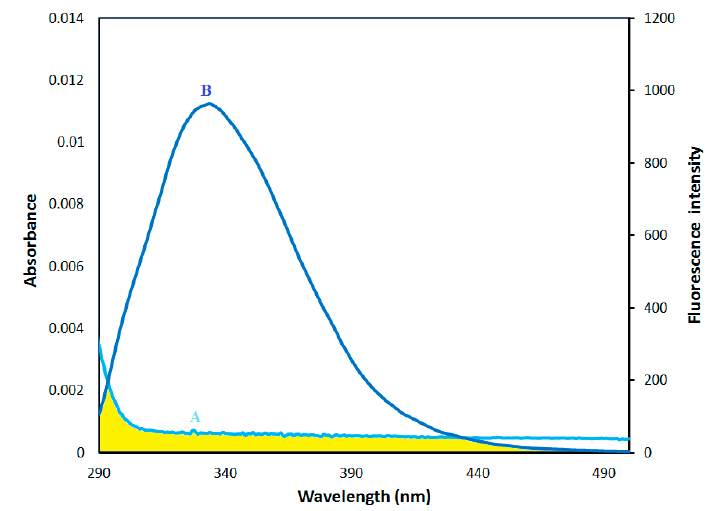
Figure 7. The overlap of (A) UV absorption spectra of AICAR (5 µ M) with (B) fluorescence spectra of HSA (5 µ M), ( λ ex = 280 nm).